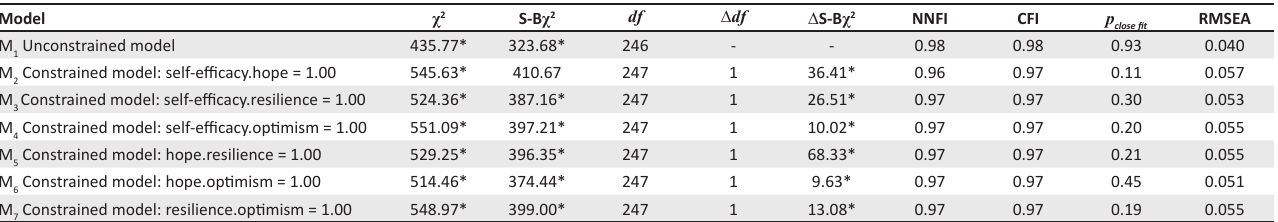
TABLE 2: Summary of goodness-of-fit statistics for the tests of discriminant validity for the Psychological Capital Questionnaire 24 subscales. Model